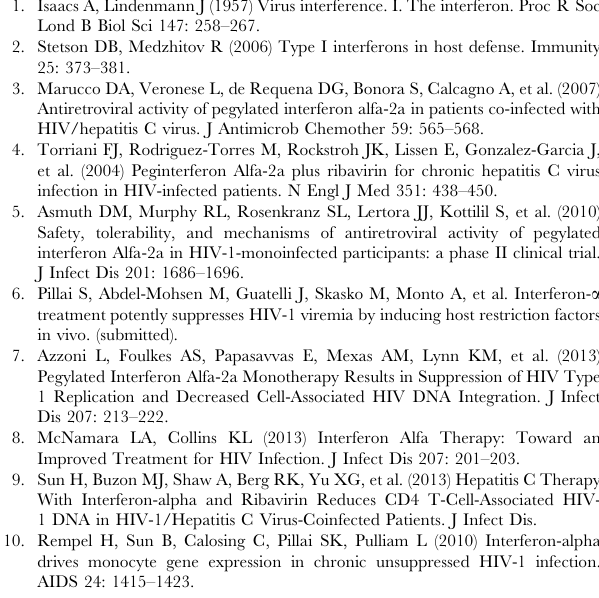
Table S1 SHCS subject characteristics at baseline (pre IFN- a /RBV treatment). Table S2 List of microRNAs modulated by IFN- a /RBV with p-value , 0.05 (pre Rx/during